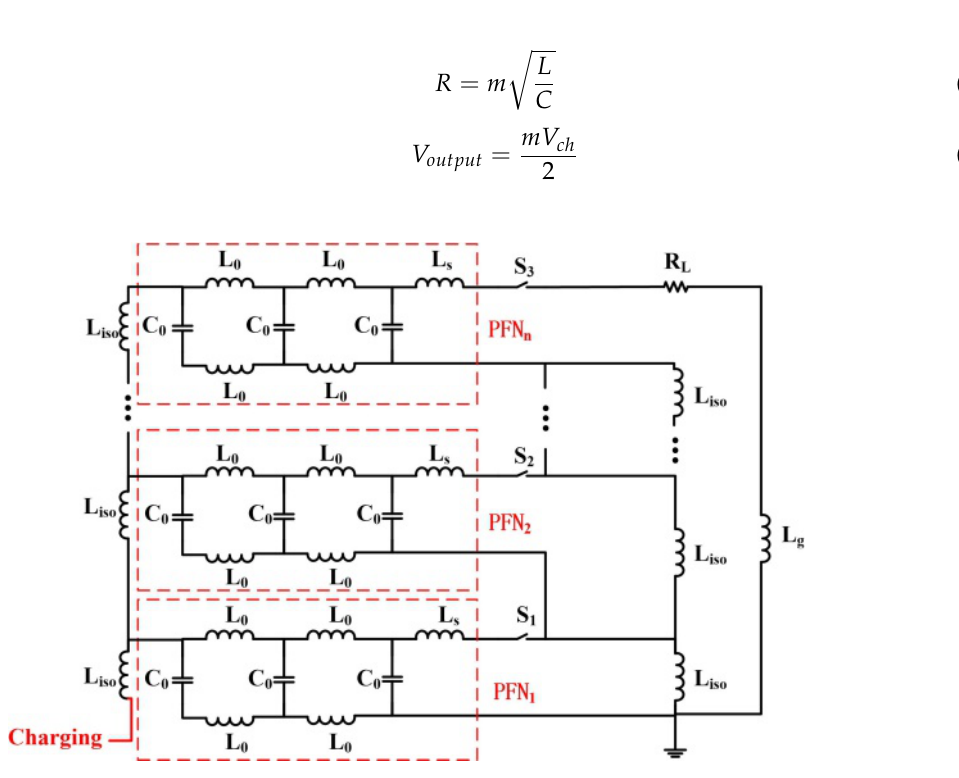
Figure 1. Schematic circuit of the PFN-Marx. Table 2. PFN-Marx generator